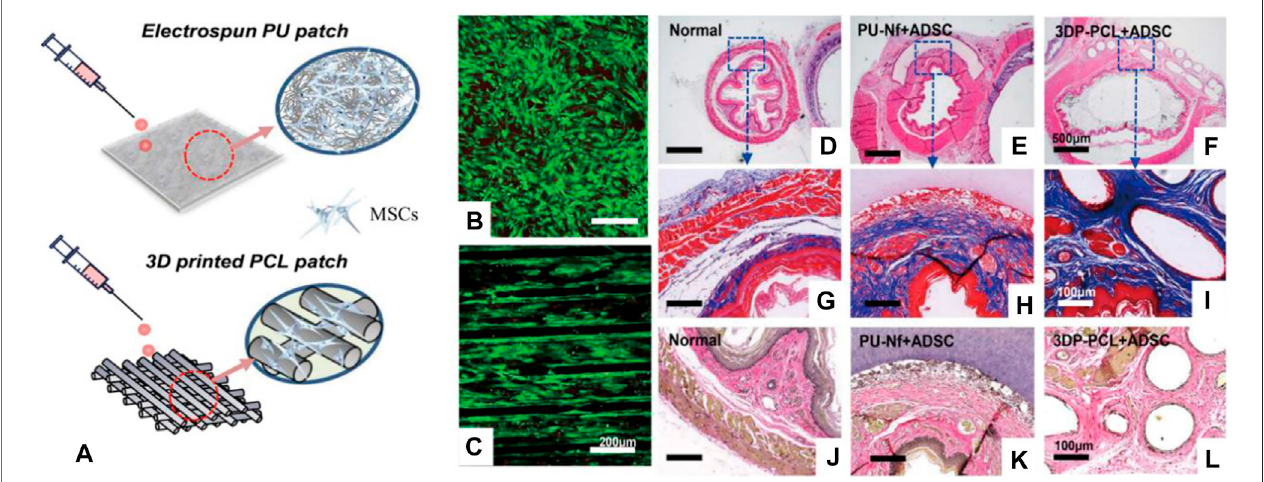
FIGURE 5 | 3D printed PCL scaffold and electrospun PU scaffold combined with MSCs to repair the esophageal defect. (A) Schematic diagram of the 3D printed PCL scaffold and electrospun PU scaffold. (B,C) The live/dead cell assay on the scaffold surface was studied. (D – F) H&E staining of rat esophagus sections. (G – I) Masson staining of rat esophagus sections. (J – L) Elastic fi ber staining of rat esophagus sections (Park et al.,